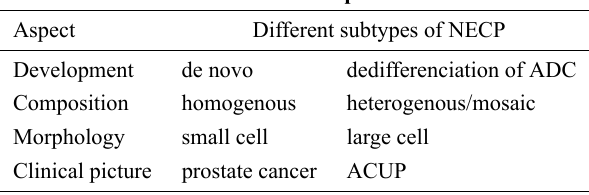
Table 1. Subtypes of neuroendocrine cancer of the prostate from different